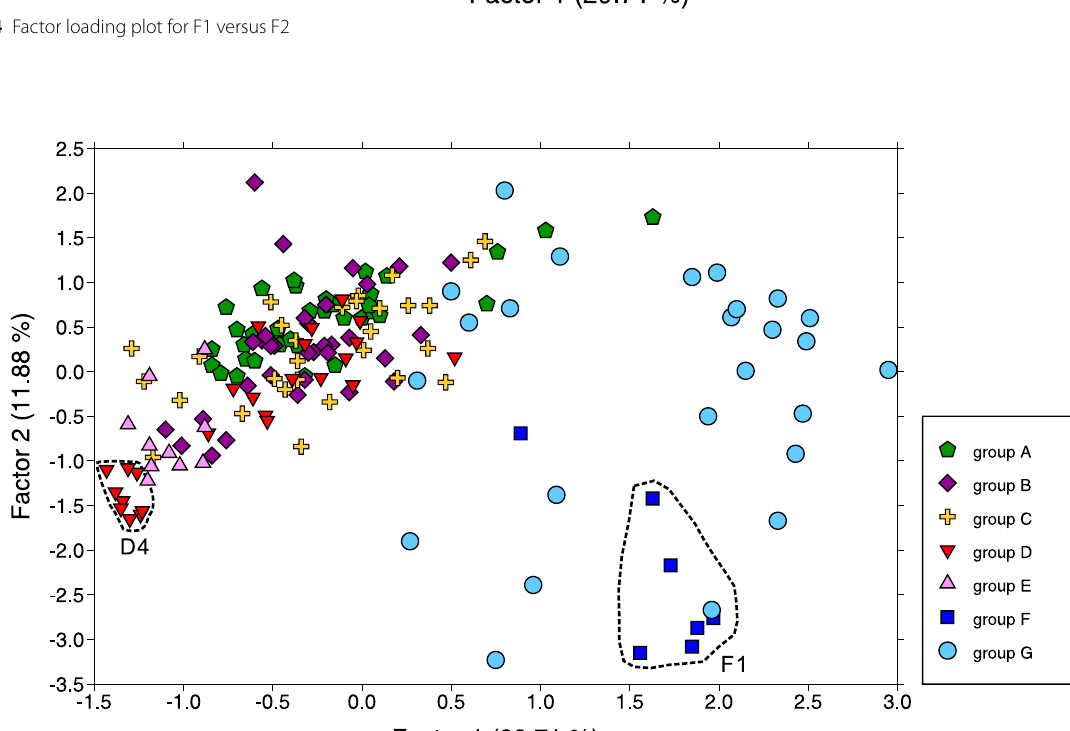
with great score variation (e.g. LGH-A7_2016-6 ver- sus LGH-A7_2016-7, LGH-B2_2015-1 versus LGH-